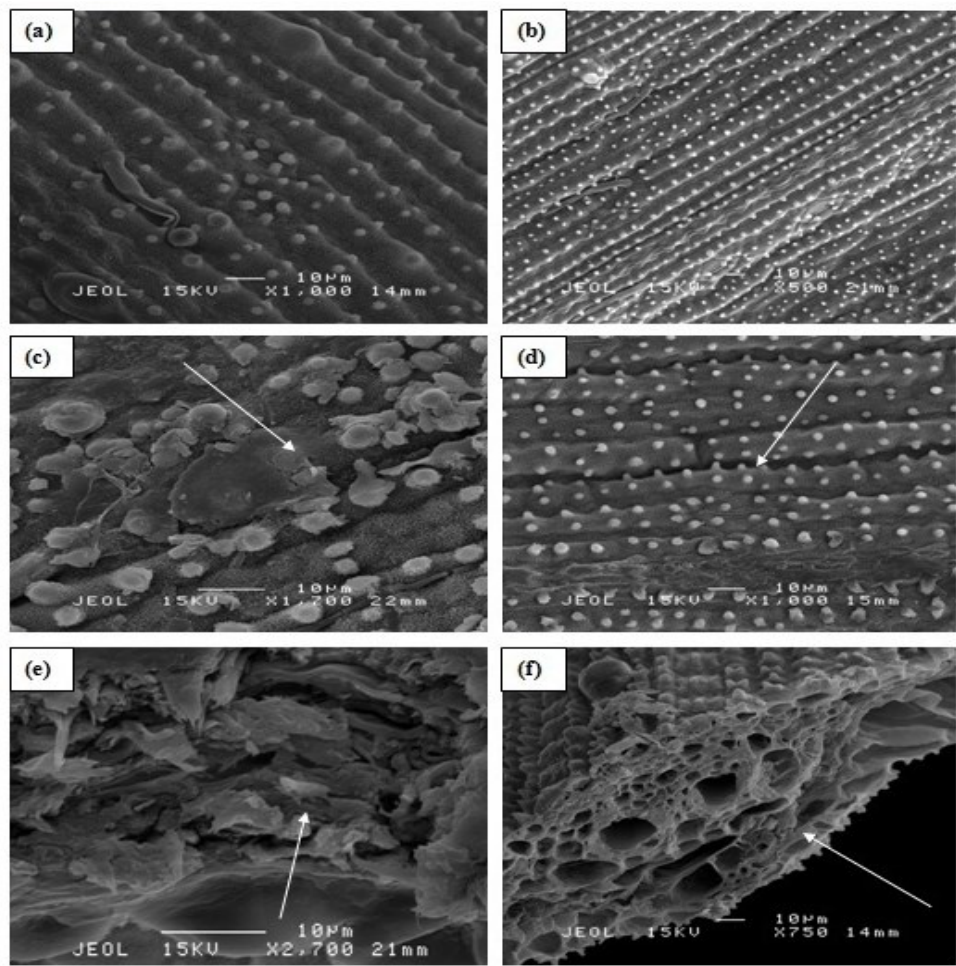
Figure 5. Scanning electron micrographs showing adaxial rice leaf surface and leaf cells: ( a ) showing leaf surface in the control treatment at 0 µM Al; ( b ) showing adaxial leaf surface inoculated with PGPB at 0 µM Al; ( c ) showing ruptured leaf surface in the control treatment at 100 µM Al; ( d ) showing PGPB inoculated leaf surface at 100 µM Al, without any rupturing; ( e ) showing internal destructive leaf cells in the control treatment at 100 µM Al; and ( f ) showing internal healthy leaf cells at 100 µM Al concentration (PGPB inoculated), arrow shows the normal leaf